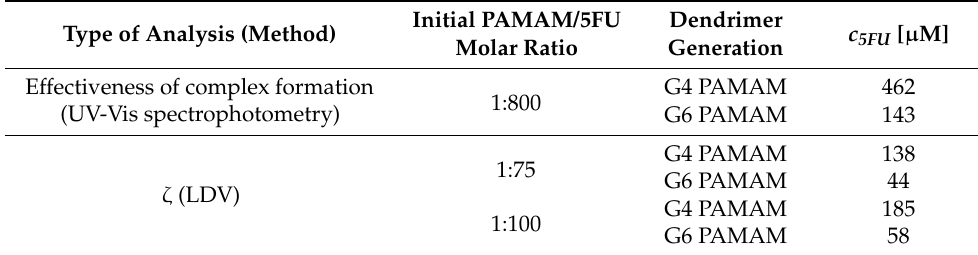
Table 2. Concentrations of 5FU in the most effective complexes (pH = 10) after dialysis depending on the method and dendrimer generation.